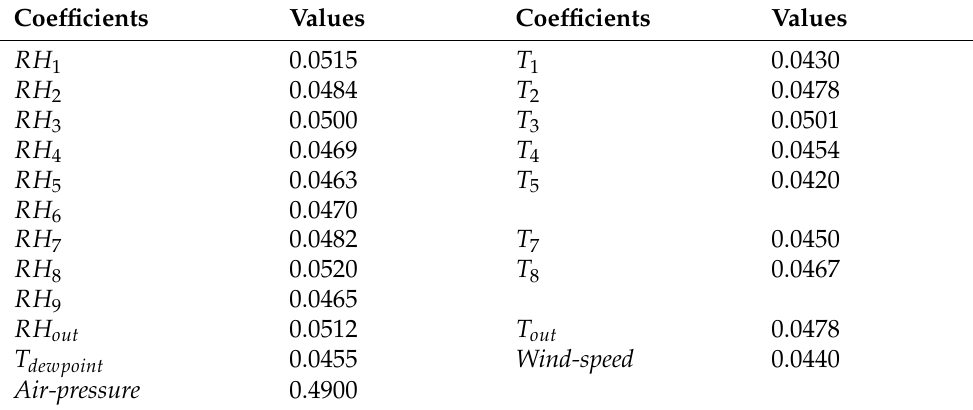
Table 15. Coefficients and weight